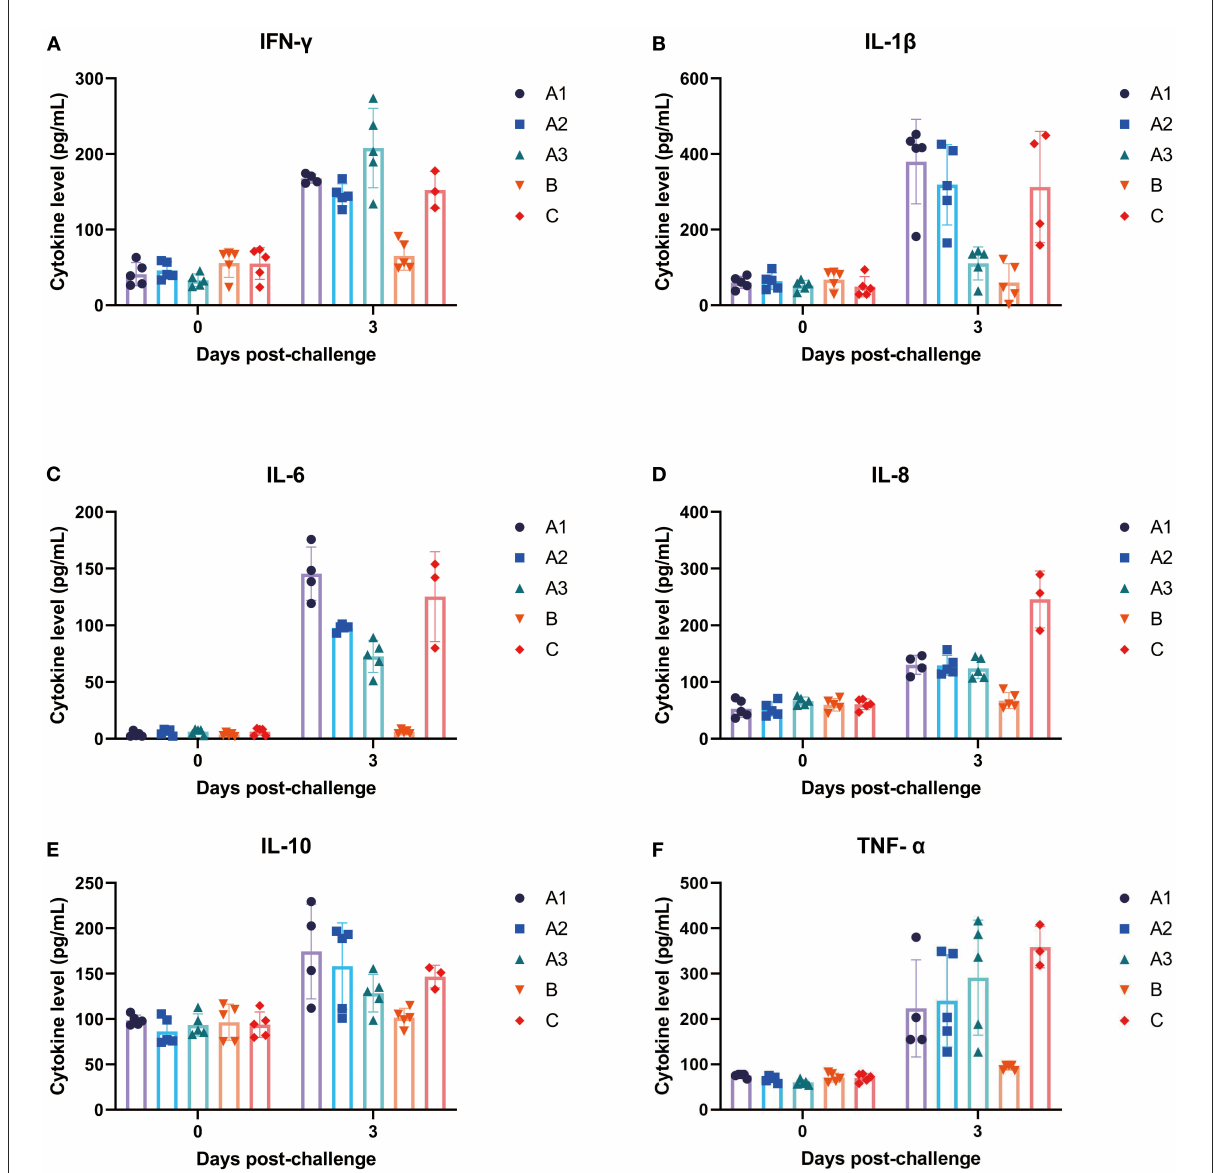
FIGURE4 The changes of different cytokines in piglets at day 0–3 were detected. (A) IFN- γ , (B) IL-1 β , (C) IL-6, (D) IL-8, (E) IL-10, and (F) TNF- α